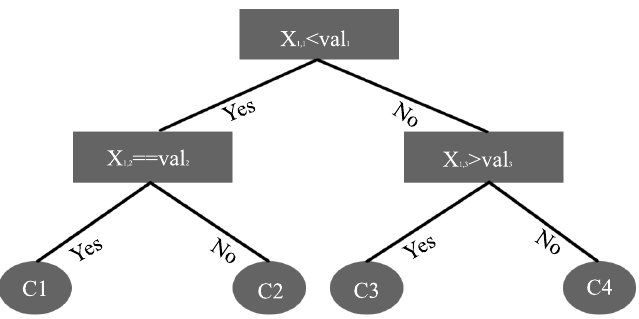
Figure 2. Decision tree architecture.